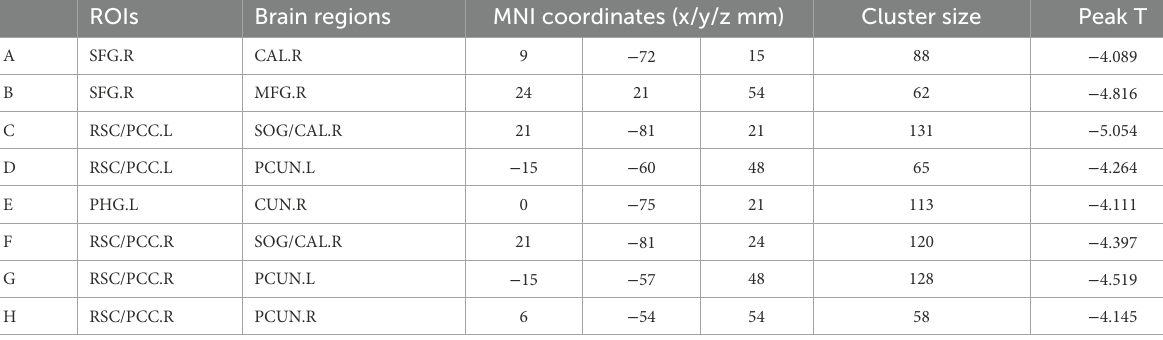
TABLE 3 Regions with decreased connectivity to DMN core ROIs in the DNR patients.